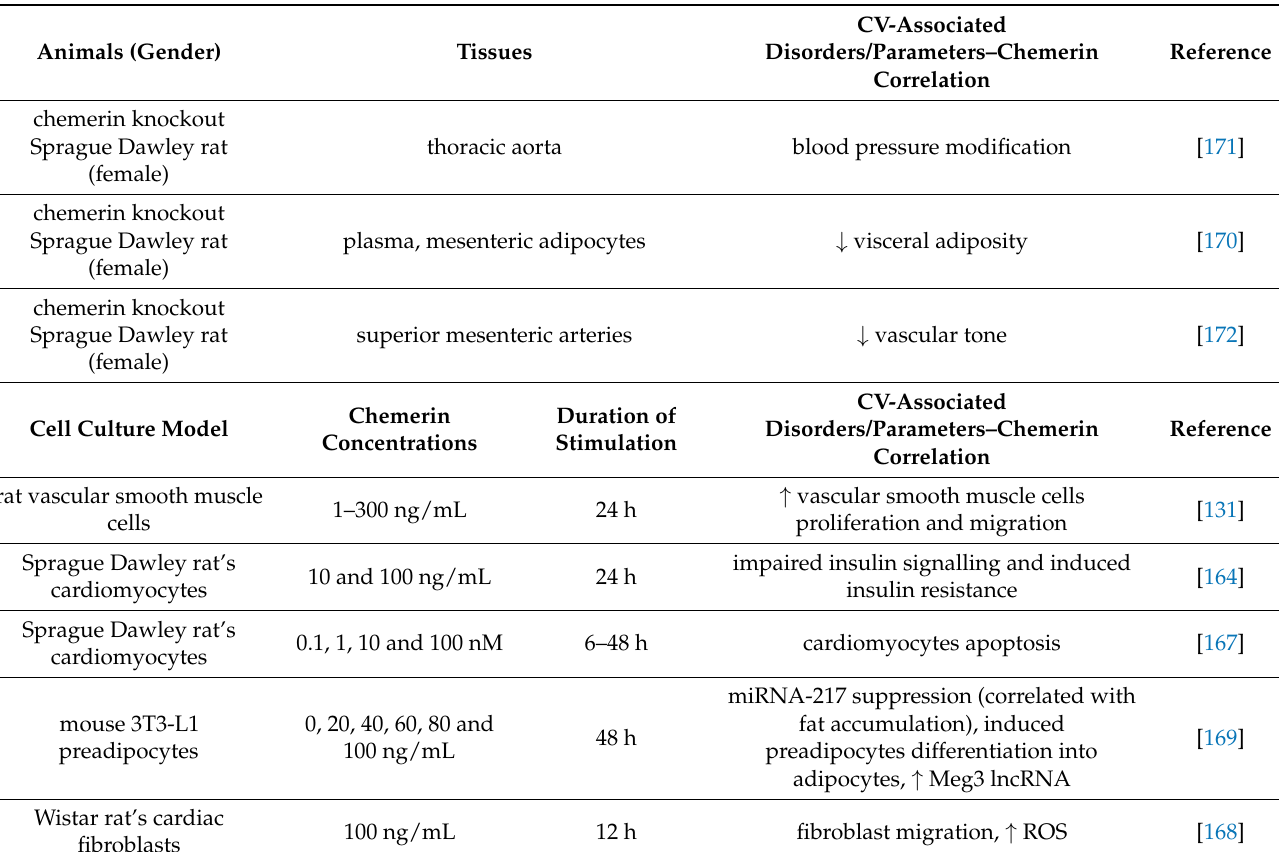
Table 2. Chemerin and CVDs: Evidence from animal